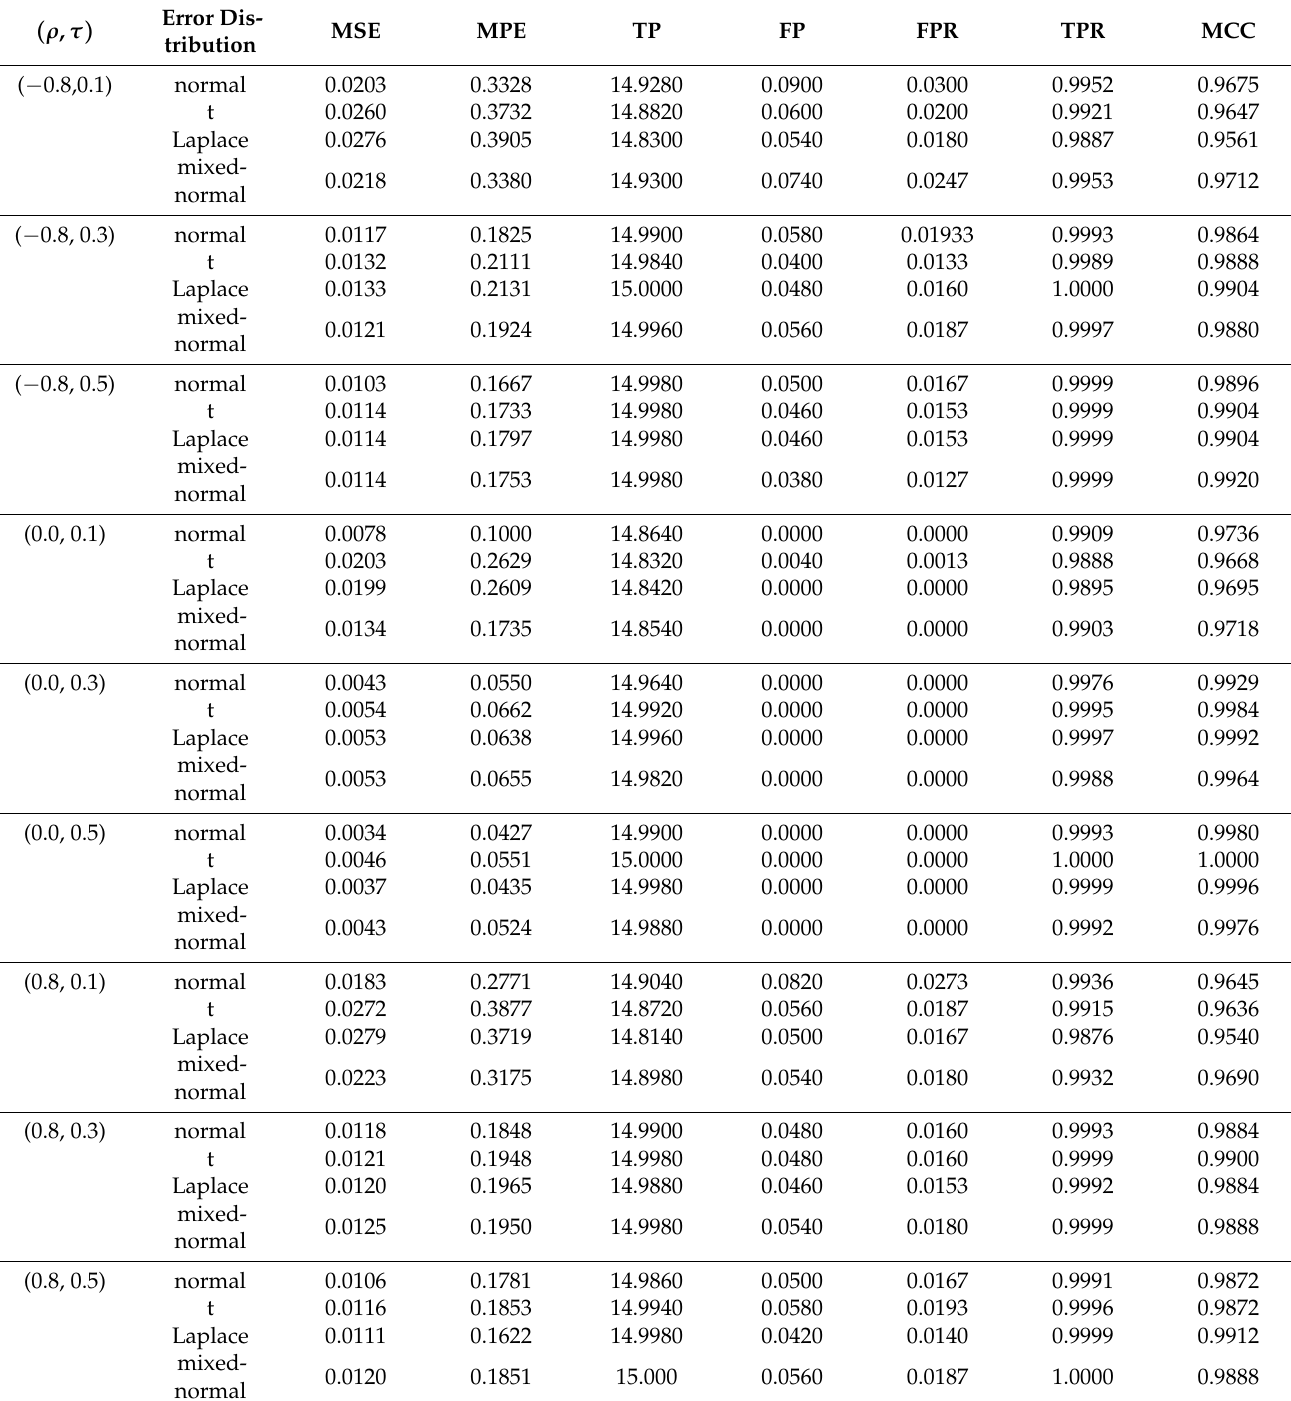
Table 4. Numerical results in the simulation study under Scenario